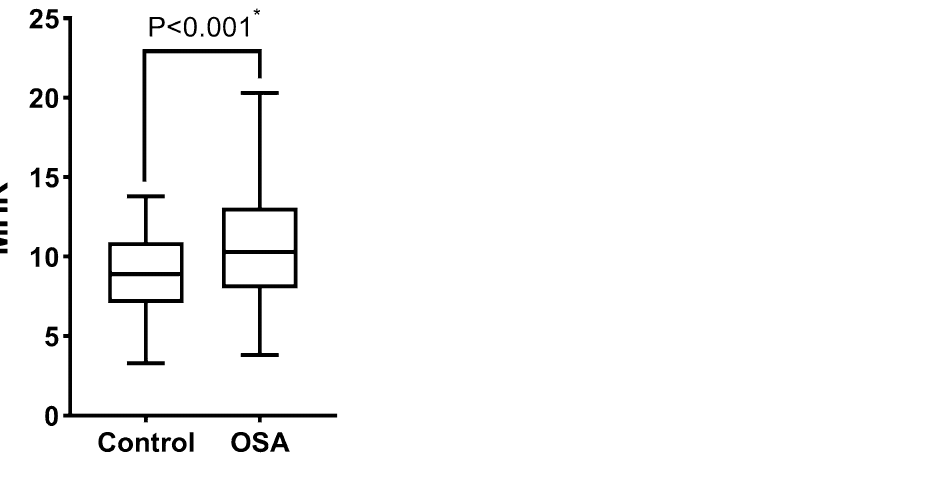
Figure 1. MHR levels in control group and the OSA group. MHR monocyte to high-density lipoprotein cholesterol ratio, OSA obstructive sleep apnea. *P value < 0.05.